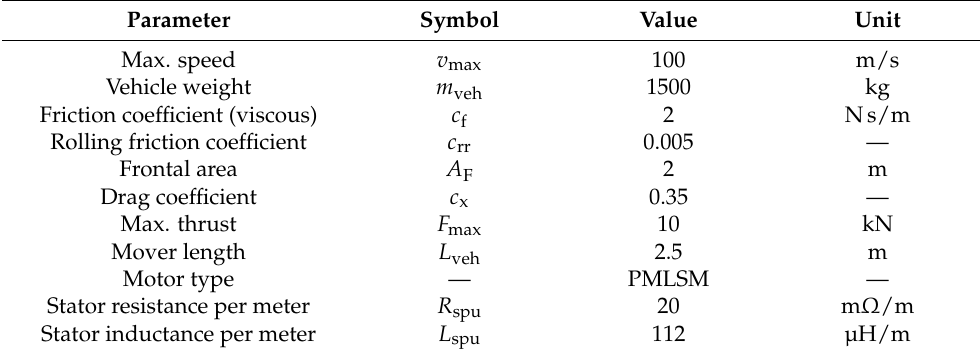
Table 1. Transportation system and drive